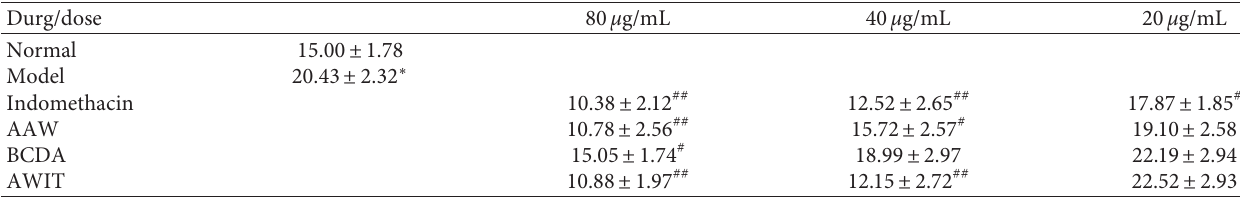
Table 3: LPS-induced release of IL-1 α in RAW264.7